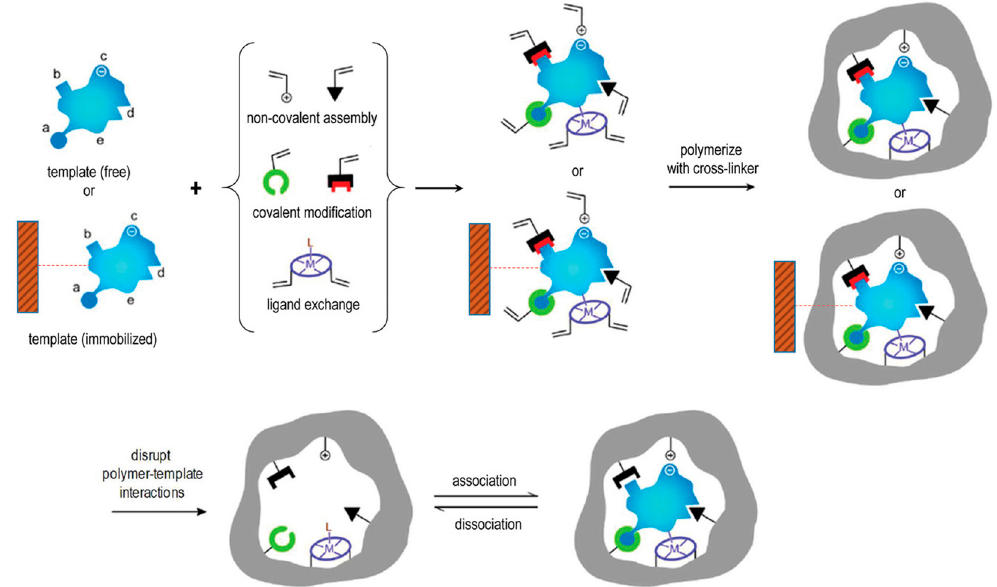
Figure 1. Scheme of the molecular imprinting process: the establishment of interactions between the template (free in solution or immobilized on a suitable solid support) and polymerizable groups interacting either covalently, non-covalently, or via co-ordination with a metal center with suitable functional groups or structural elements of the template. Subsequent polymerization in presence of a cross-linker develops a porous insoluble matrix containing the binding sites for the template. At this point, either the template is removed (if free), or alternatively the polymer is separated from the immobilized template in suitable washing/elution conditions. In all cases the target analyte can selectively rebind to the polymer into the sites formed by the template, or “imprints”. Reproduced with permission from Patel et al. [29].